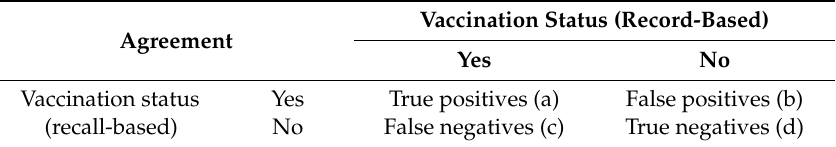
Table 1. Two-by-two table for calculating the sensitivity and specificity.